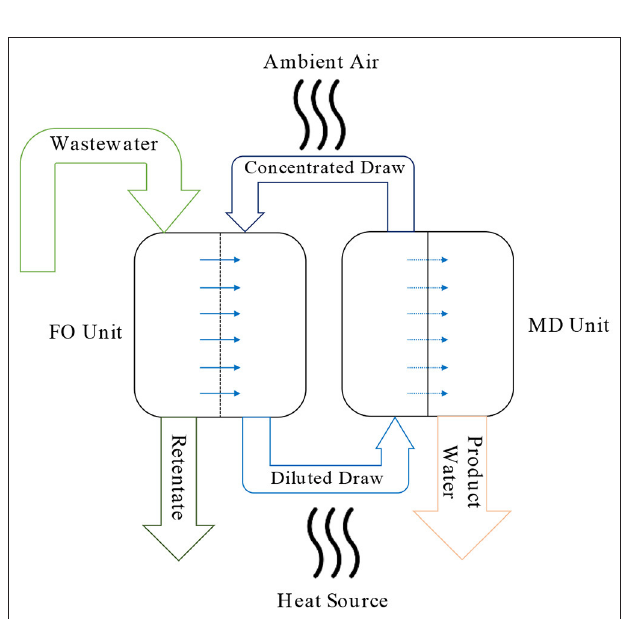
FIGURE 3 | Schematic diagram of the FO-MD hybrid wastewater treatment system. The hot water produced by the CHP engine acts as the “Heat